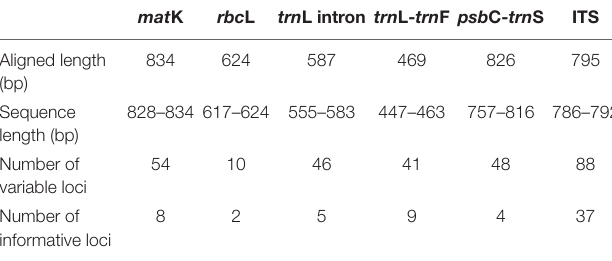
TABLE 2 | Sequence attributes of the five loci used in this study.